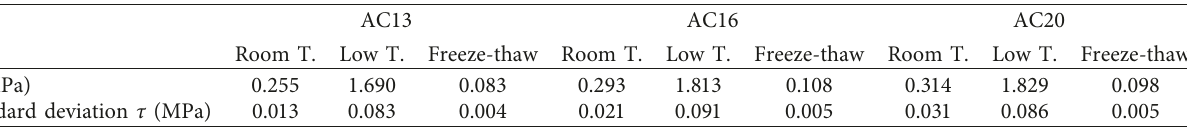
Table 10: Results of shear test of asphalt mixture.